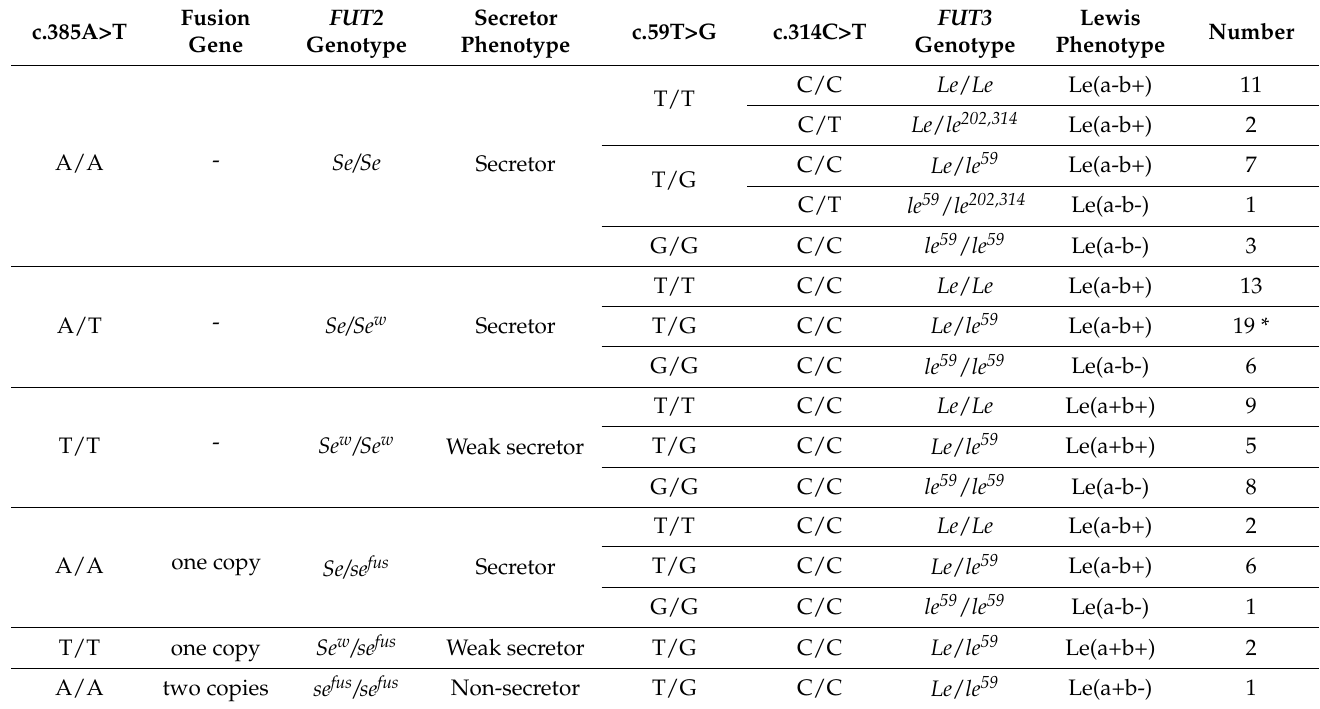
Table 1. FUT2 and FUT3 genotypes and secretors and Lewis blood group phenotypes estimated by the triplex